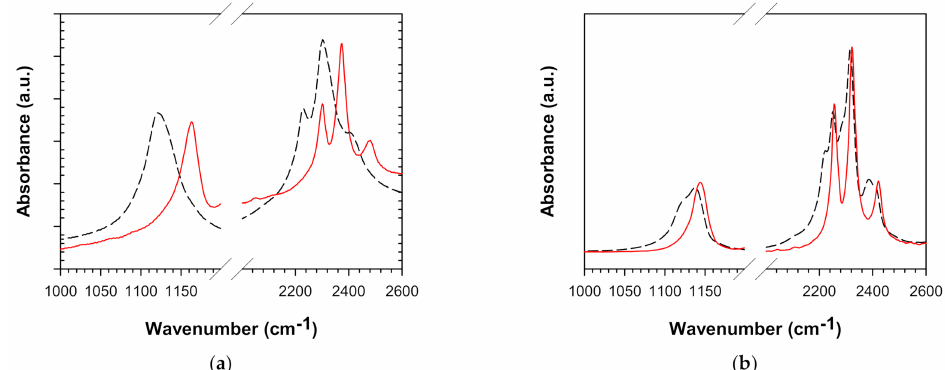
Figure 3. IR spectra of NaBH 4 diluted in ( a ) NaCl and ( b ) KCl pellets before (black dashed lines) and after thermal treatment to 450 ◦ C (red solid lines).